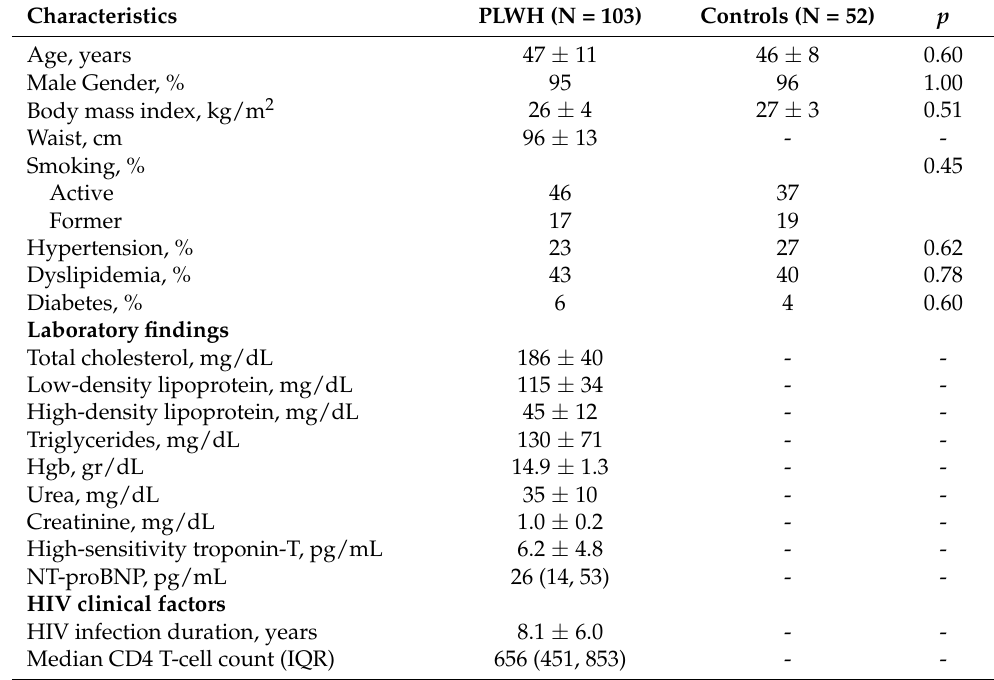
Table 1. Demographic and clinical characteristics of PLWH and